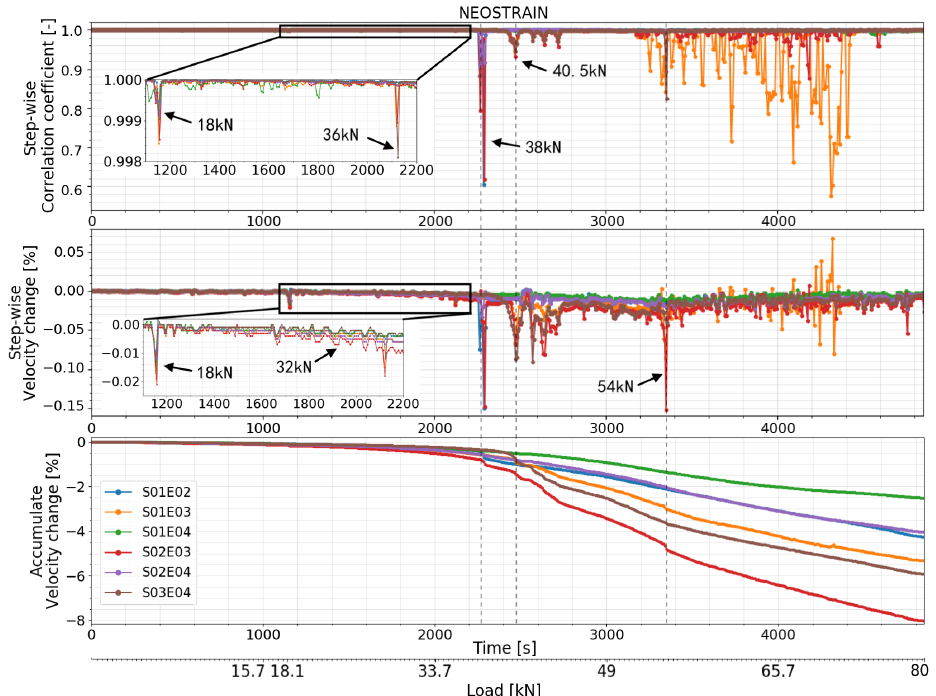
Figure 20. Correlation coefficient and relative velocity change of all the transducers combinations in test at NEOSTRAIN calculated by step-wise and accumulate